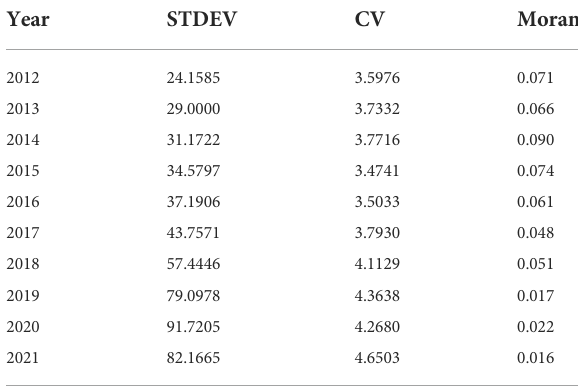
TABLE 2 Annual index of remote sensing research